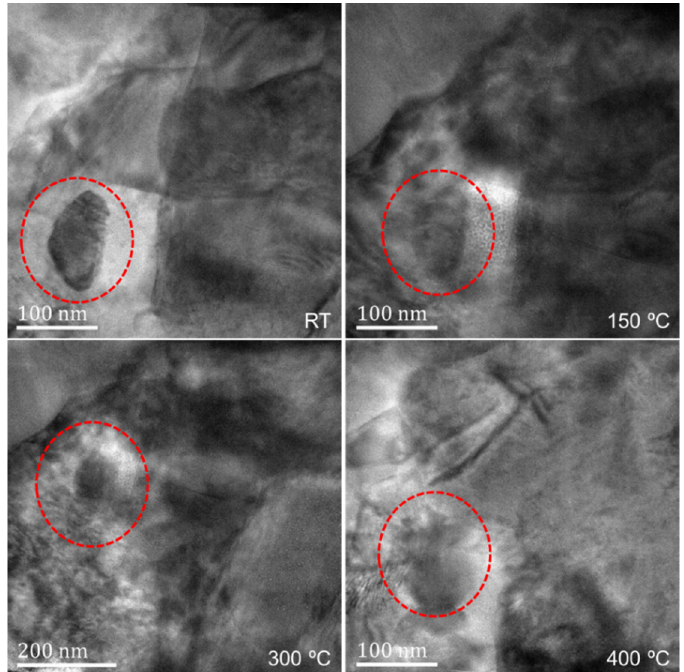
Figure 8. Morphology of TC/TGO interface at different temperatures.